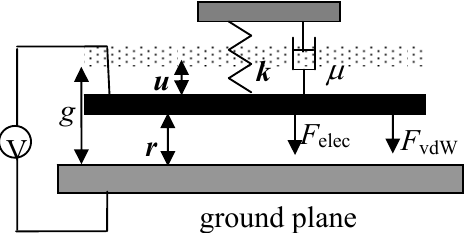
Figure 1. 1DLM for the parallel-plate